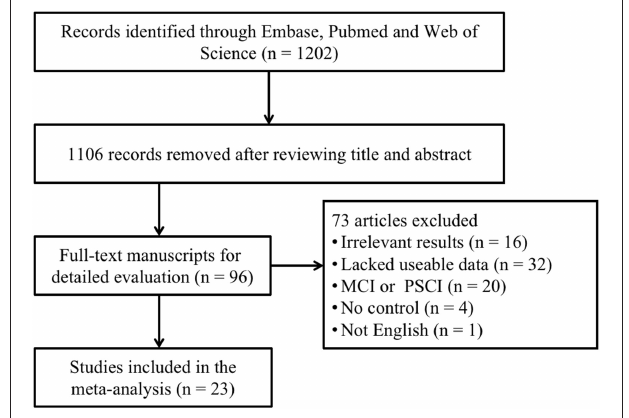
FIGURE 1 | A flowchart of the screening of the study and the selection in the meta-analysis. MCI, mild cognitive impairment; PSCI, post-stroke cognitive